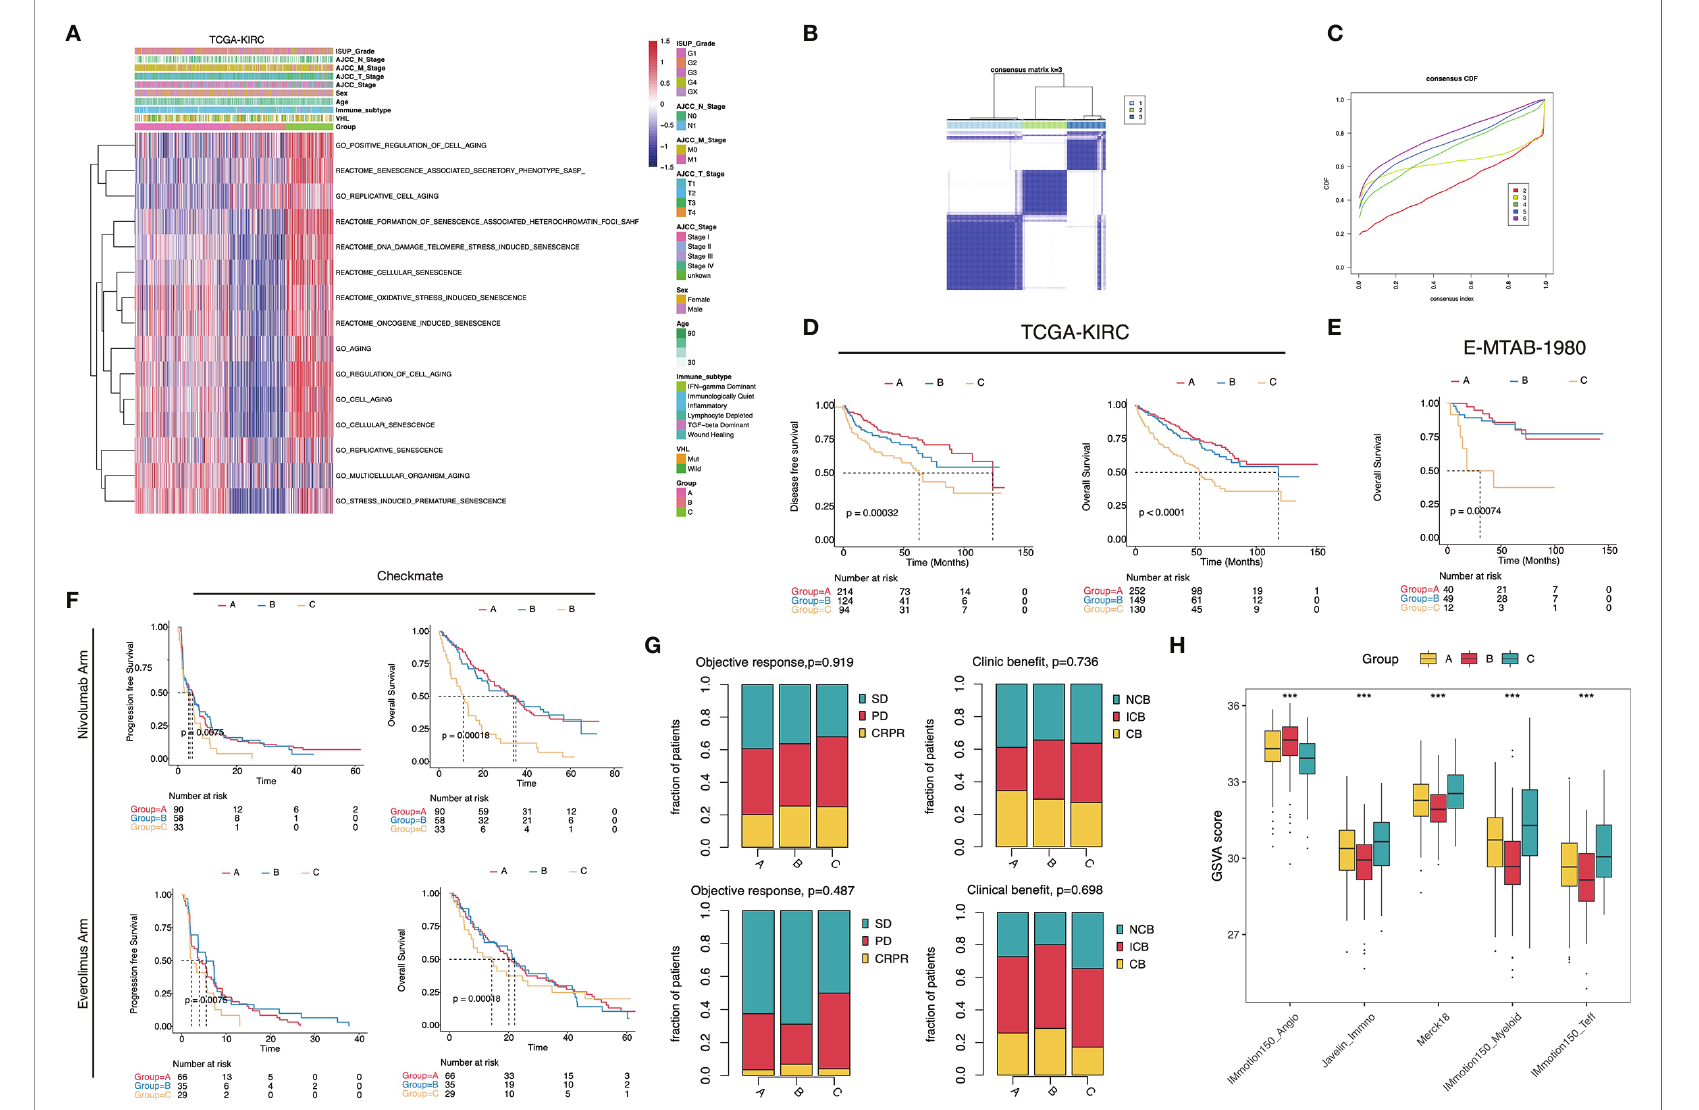
FIGURE 2 | Senescence subtype was correlated with strati fi ed patients ’ prognosis and treatment bene fi ts. (A) Heatmap of the 15 senescence-related biological processes of the senescence subtypes in TCGA- KIRC. (B) The heatmap of the k-means consensus clustering result. (C) CDF curves of the consensus clustering. (D – F) Kaplan – Meier curves showed the survival difference among the senescence subtypes in TCGA-KIRC (D) , E-MTAB-1980 (E) , and Checkmate (F) . Log-rank test. (G) Bar plots displayed the proportion of objective response and clinical bene fi t rates among the senescence subtypes in Checkmate. (H) Boxplot showed the difference of the VEGF- and in fl ammatory-related signature scores in Checkmate. ***,